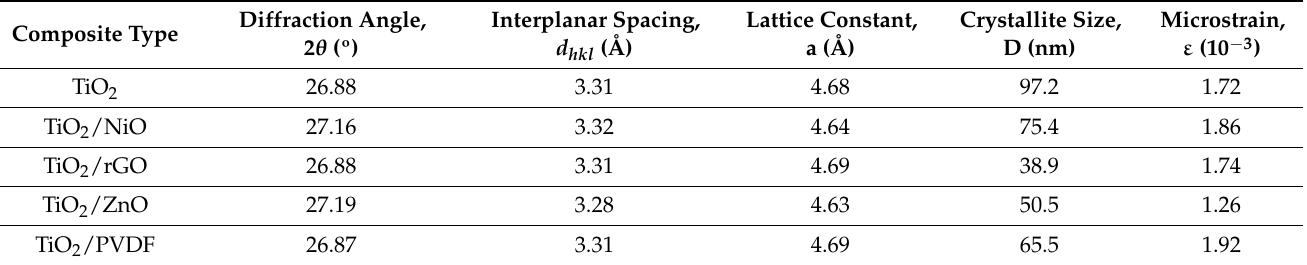
Figure 5. ( a ) XRD patterns of different TiO 2 composites, ( b ) Crystallite size and microstrain of all samples. Table 1. Diffraction angle, interplanar spacing, lattice constant, crystallite size, microstrain, and dislocation density of different TiO 2